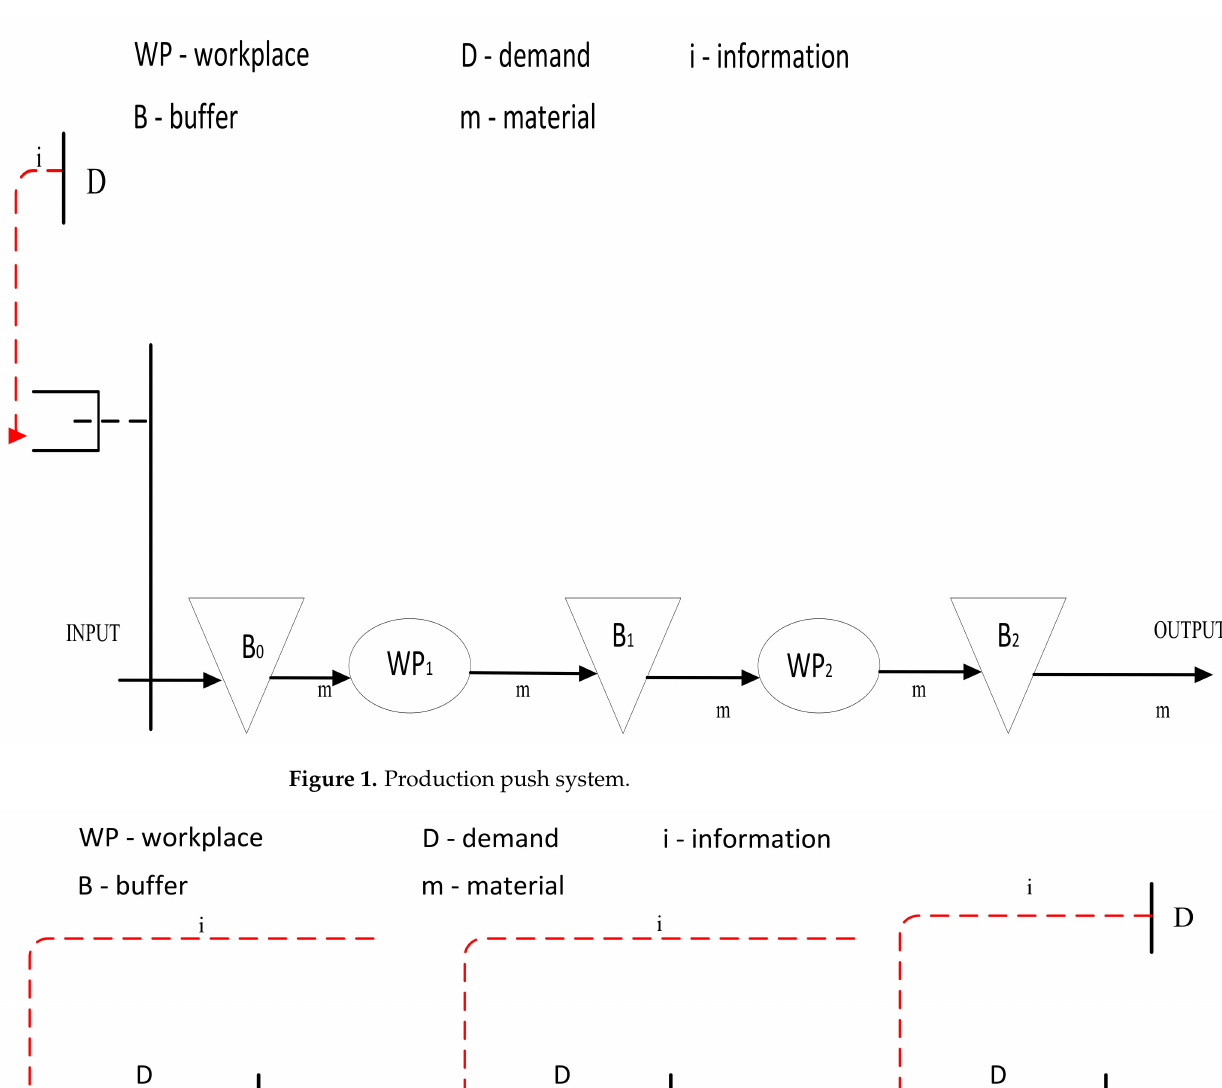
Figure 2. Production pull